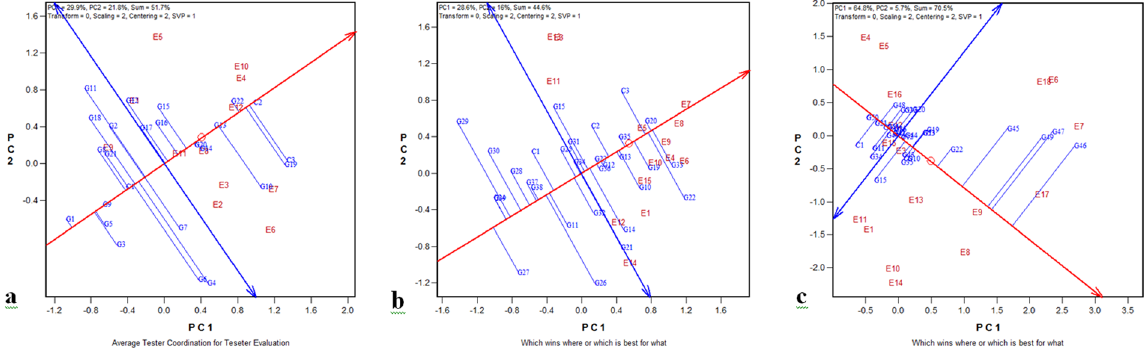
Figure 2. GGE biplot of mean and stability of rice genotypes for yield and specific genotype × environment interactions in ( a ) 2011, ( b ) 2012, and ( c ) 2013.